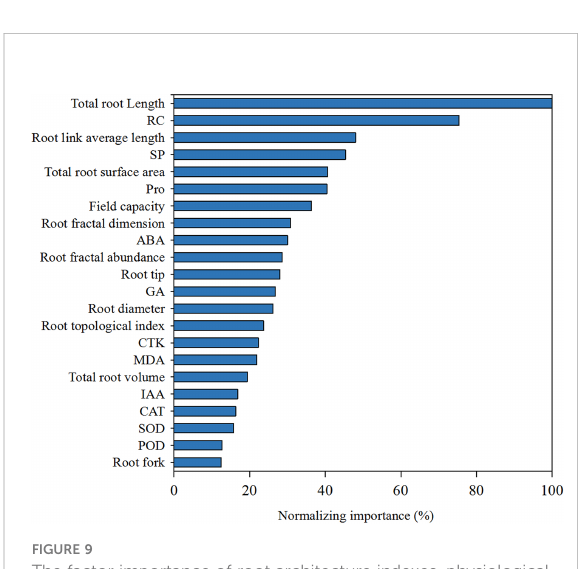
FIGURE 9 The factor importance of root architecture indexes, physiological indexes and Field capacity to root biomass at seedling stage of K. hirsuta